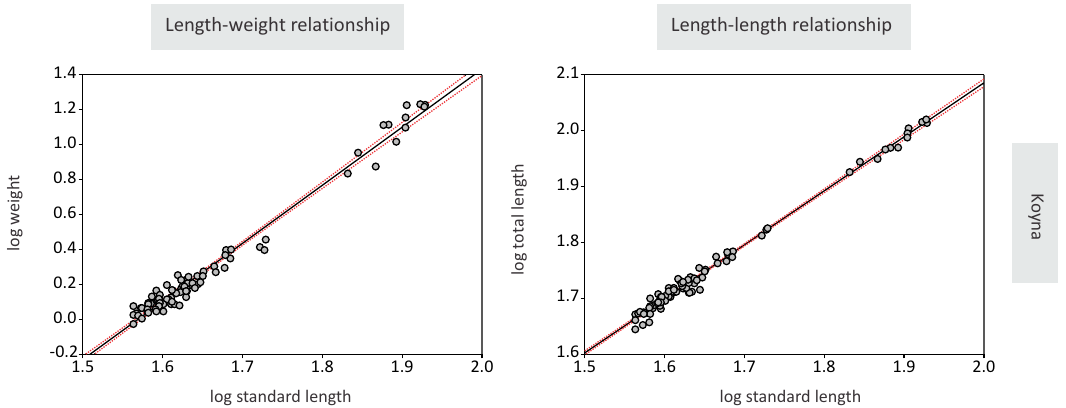
Appendix A. Scatter plots for Botia striata . Dashed lines are 95% confidence intervals for the regression